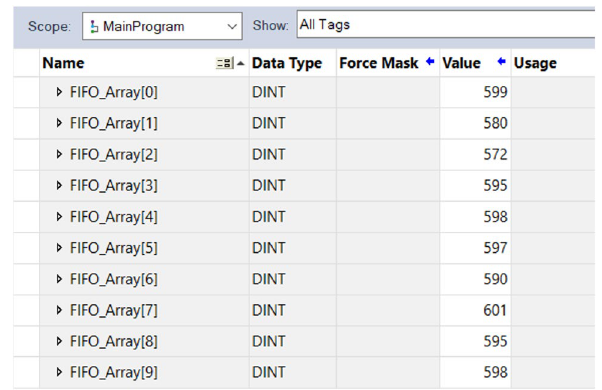
Fig. 15 Capturing several values of the scan time